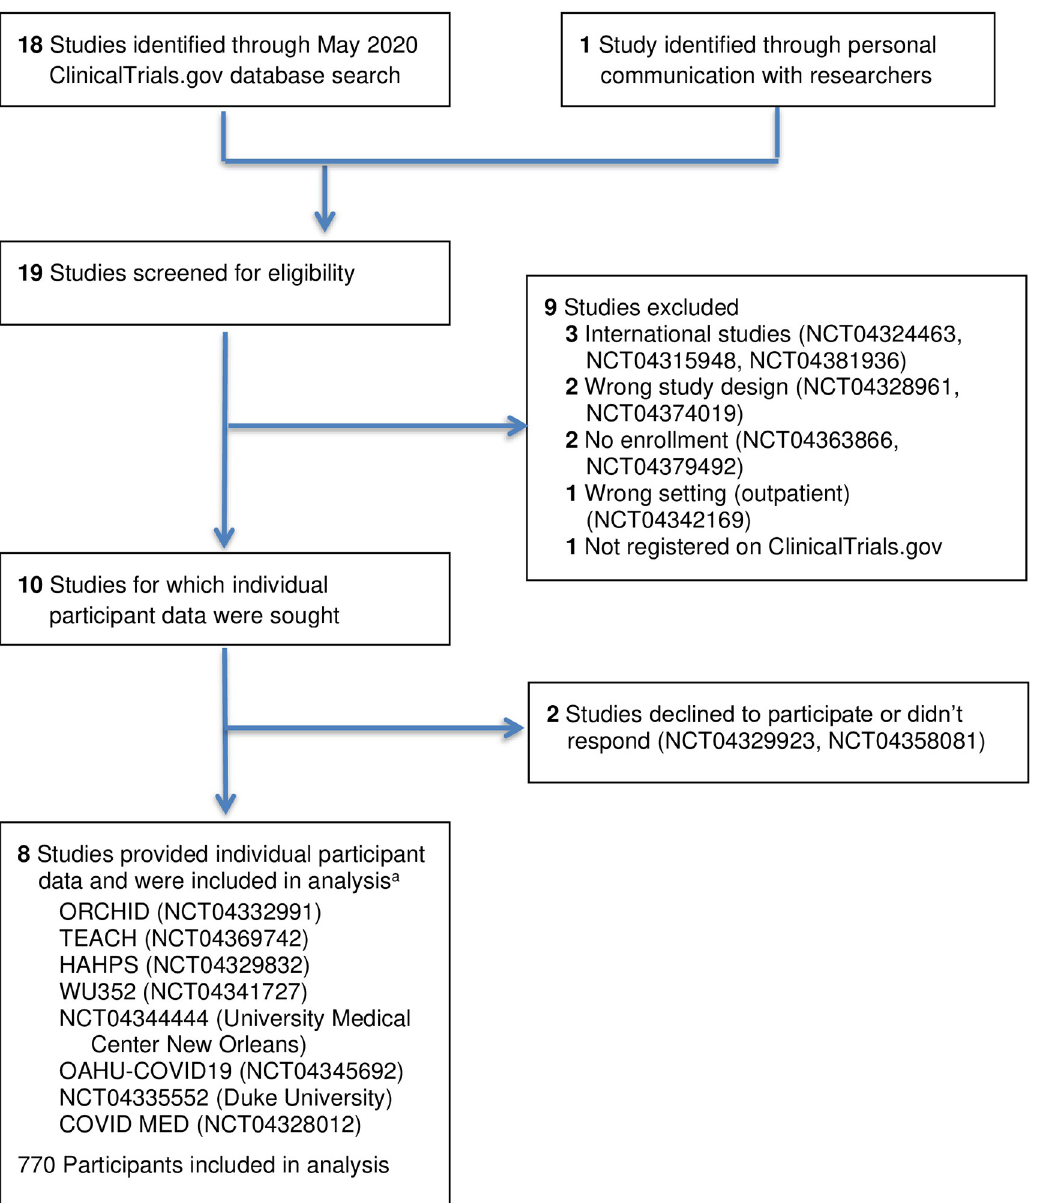
Fig 1. Trial selection process. a Two of the trials did not have study acronyms (only trial registration numbers). Abbreviations: COVID MED, Comparison Of Therapeutics for Hospitalized Patients Infected With SARS-CoV-2 In a Pragmatic aDaptive randoMizED Clinical Trial During the COVID-19 Pandemic; HAHPS, Hydroxychloroquine vs. Azithromycin for Hospitalized Patients With Suspected or Confirmed COVID-19; OAHU-COVID19, A Randomized, Controlled Clinical Trial of the Safety and Efficacy of Hydroxychloroquine for the Treatment of COVID-19 in Hospitalized Patients; ORCHID, Outcomes Related to COVID-19 Treated With Hydroxychloroquine Among In-patients With Symptomatic Disease; TEACH, Treating COVID-19 With Hydroxychloroquine; WU352, Washington University 352: Open-label, Randomized Controlled Trial of Hydroxychloroquine Alone or Hydroxychloroquine Plus Azithromycin or Chloroquine Alone or Chloroquine Plus Azithromycin in the Treatment of SARS CoV-2